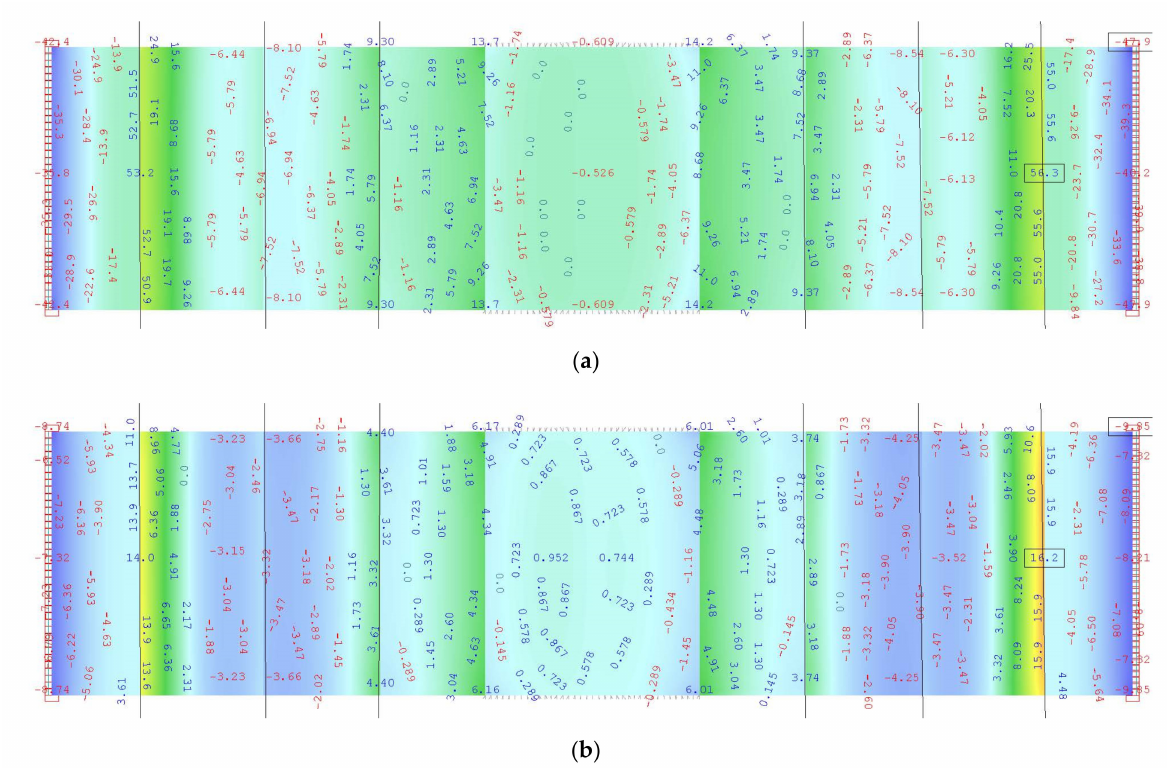
Figure A2. Maps of characteristic values of bending moments M xx (kNm) in the concrete arch: ( a ) Dead weight; ( b ) bridge equipment loads.